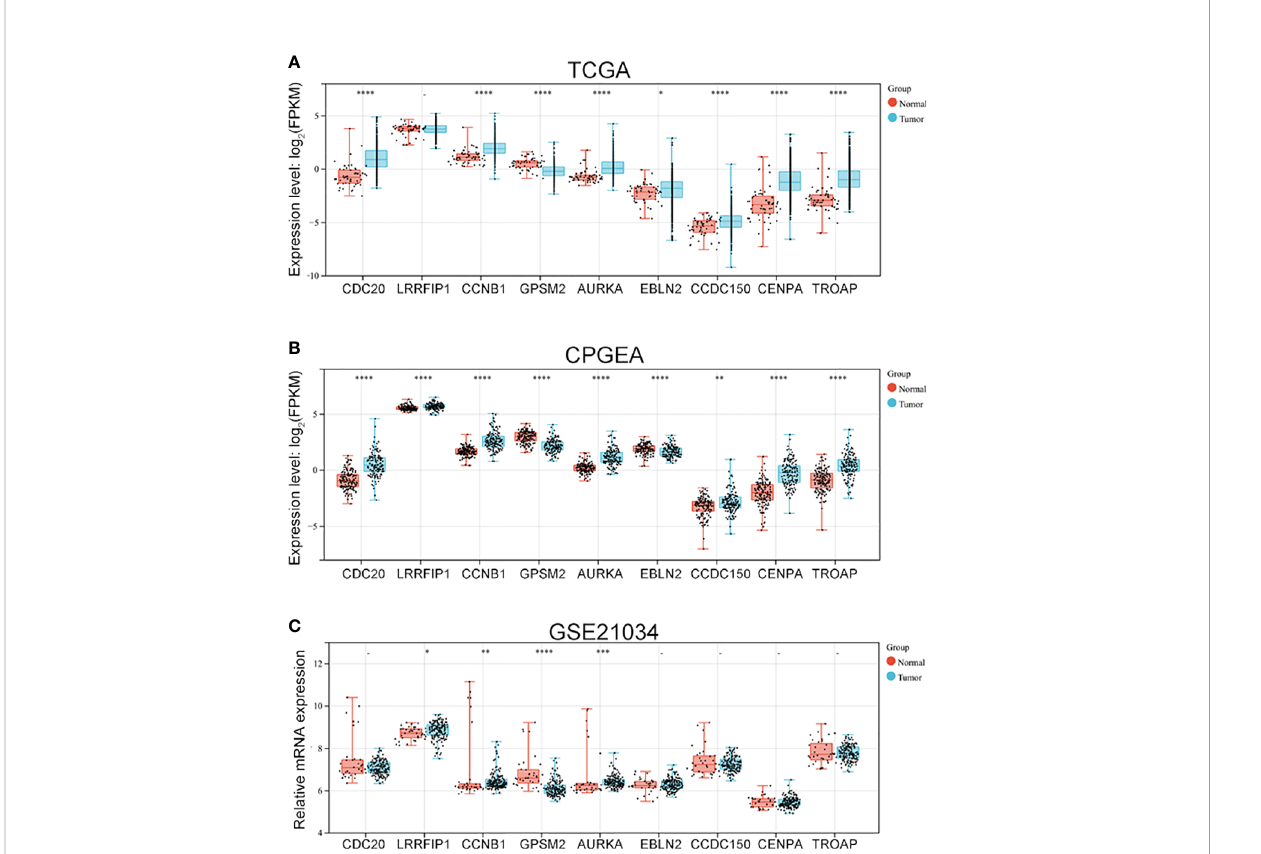
FIGURE 3 The expression of vinblastine resistance-related genes in PCa patients from different databases. Expression of nine vinblastine resistance-related hub genes in PCa patients from TCGA (A) database, CPGEA (B) database, and GSE21034 (C) dataset. – represents no statistical differences. * represents P <0.05, ** represents P <0.01, *** represents P <0.001, **** represents P